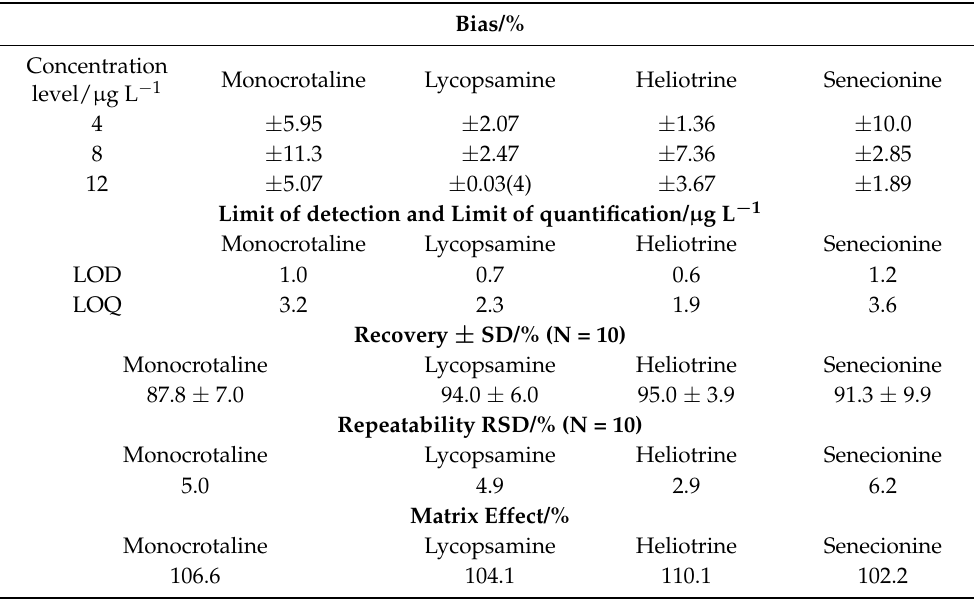
Table 4. Validation parameters of the presented method using HNT-MPTMS-SO 3 H and 12.5 µ g L − 1 spiked honey